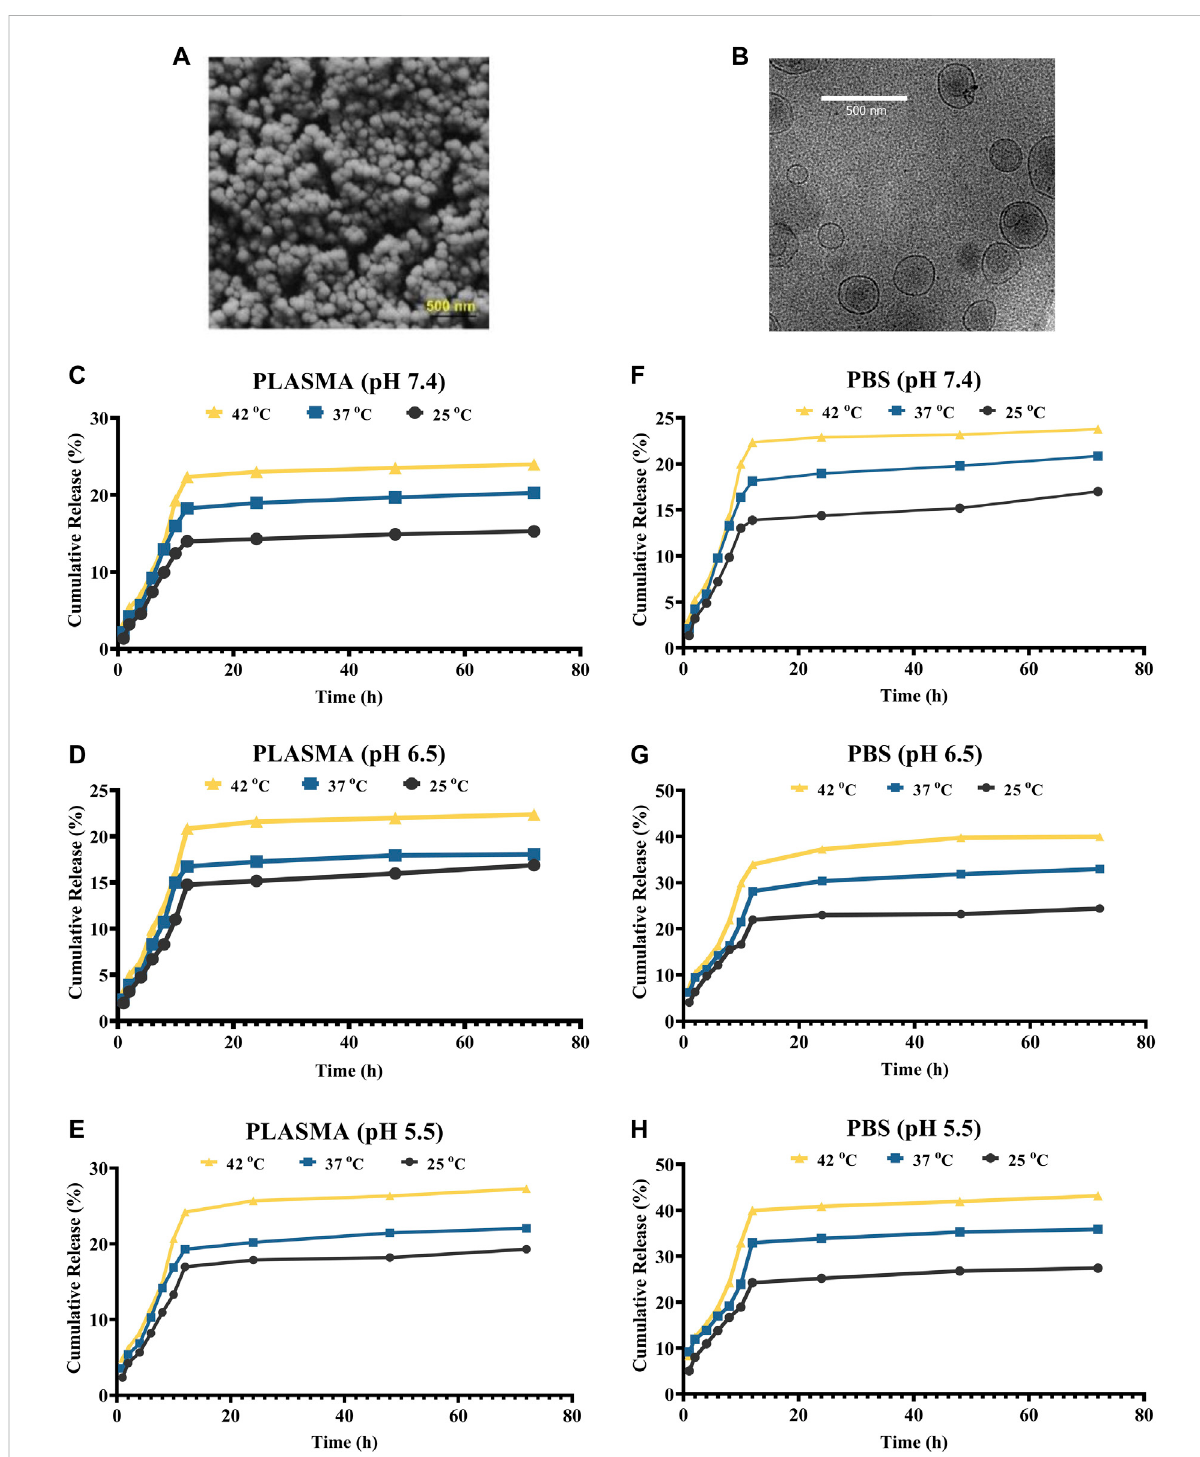
FIGURE 2 (A,B) SEMandcryo-TEMoftheloadedniosomes,respectively. (C – E) ReleaseofCurinplasmasolutionatthepHof7.4,6.5,and5.5,respectively. (F – H) Release of Cur in PBS solution at the pH of 7.4, 6.5, and 5.5,